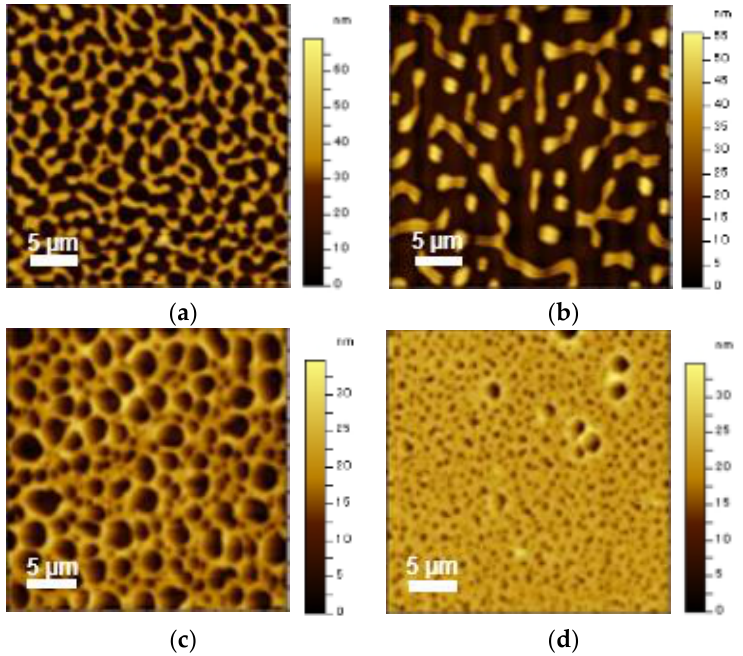
Figure 4. SFM height images of ( a ) poly(BPVS-An)- b -poly(NVC); ( b ) poly(BPVS-PAn)- b -poly(NVC); ( c ) poly(BPVS-An- ran -NVC); and ( d ) poly(BPVS-PAn- ran -NVC). The films were prepared by drop-casting onto mica substrates (conc. = 2.0 mg/mL in THF).